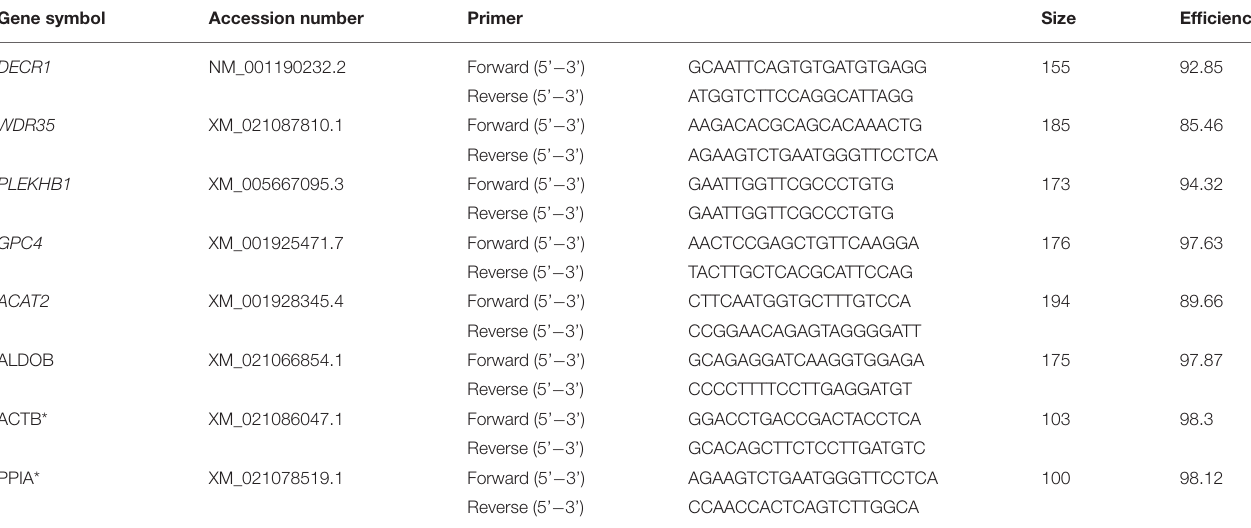
TABLE 1 | Sequences of the primers used for validation of the microarray by quantitative real-time PCR (RT-qPCR) analysis.